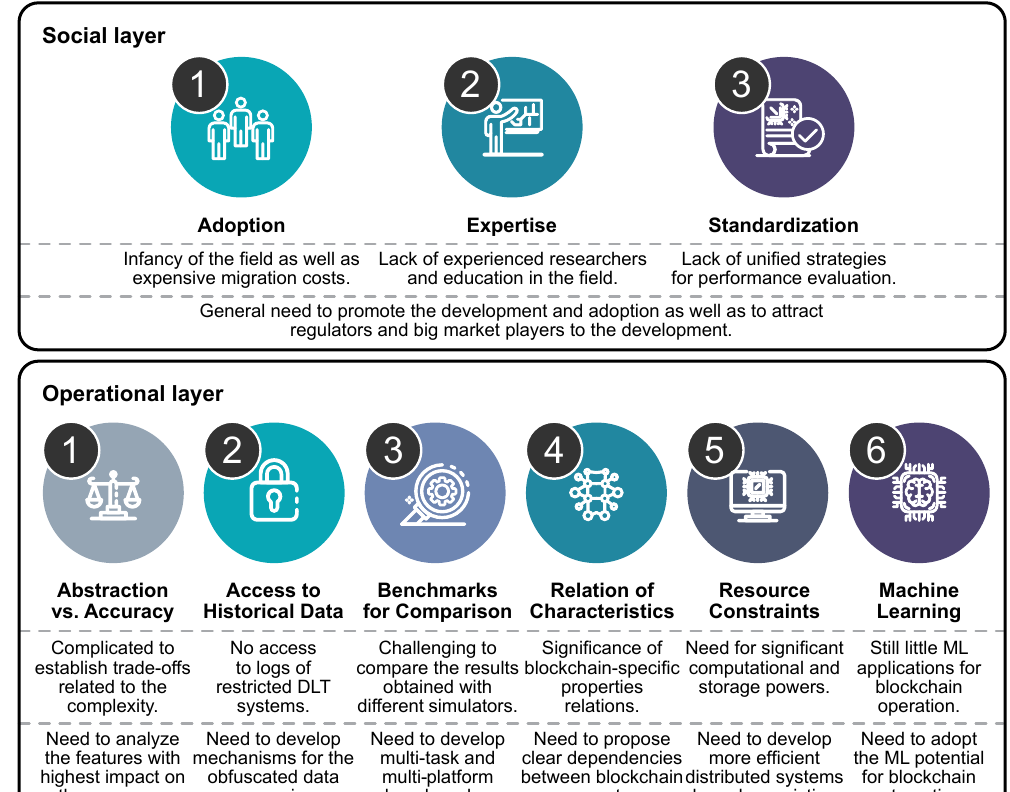
Figure 2. Challenges and perspectives of blockchain simulation